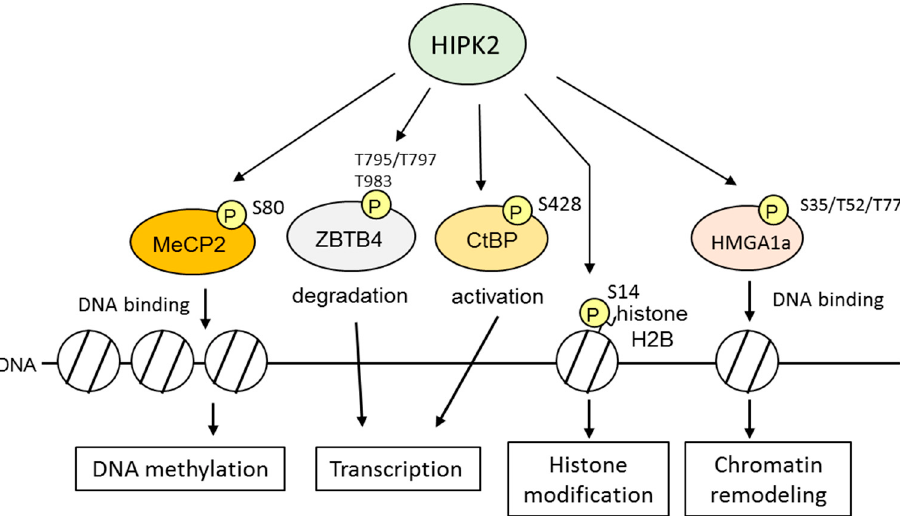
Figure 3. HIPK2 targets in epigenetic regulation. HIPK2 phosphorylates and activates epigenetic factors which are involved in DNA methylation, histone modification, chromatin remodeling, and transcription. Phosphorylated sites (P) by HIPK2 are shown.